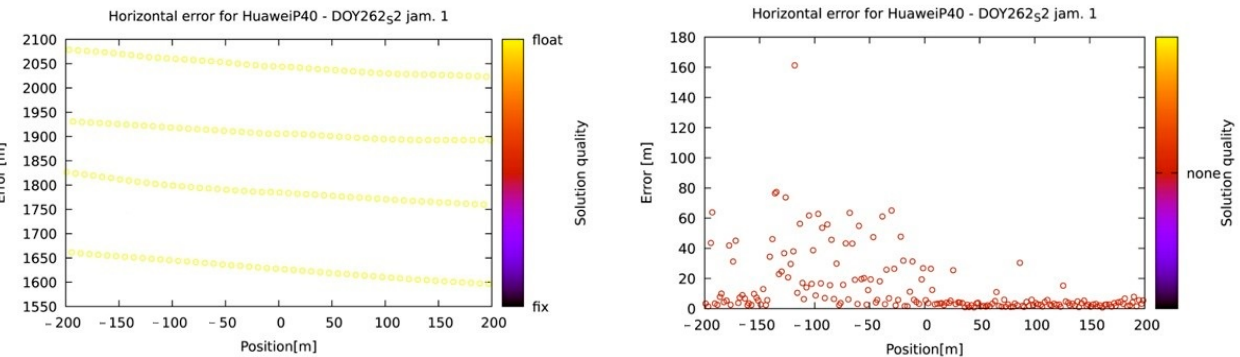
Figure 15. Comparison between results given using different software: RTKLIB (left) and Leica Infinity (right).